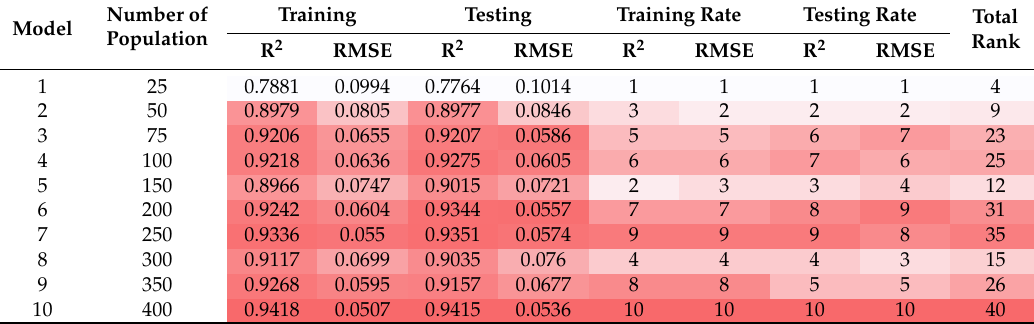
Figure 11. PIs changes for testing section of GA-ANN models. Table 3. Ranking and CIR systems to select the best GA-ANN model.